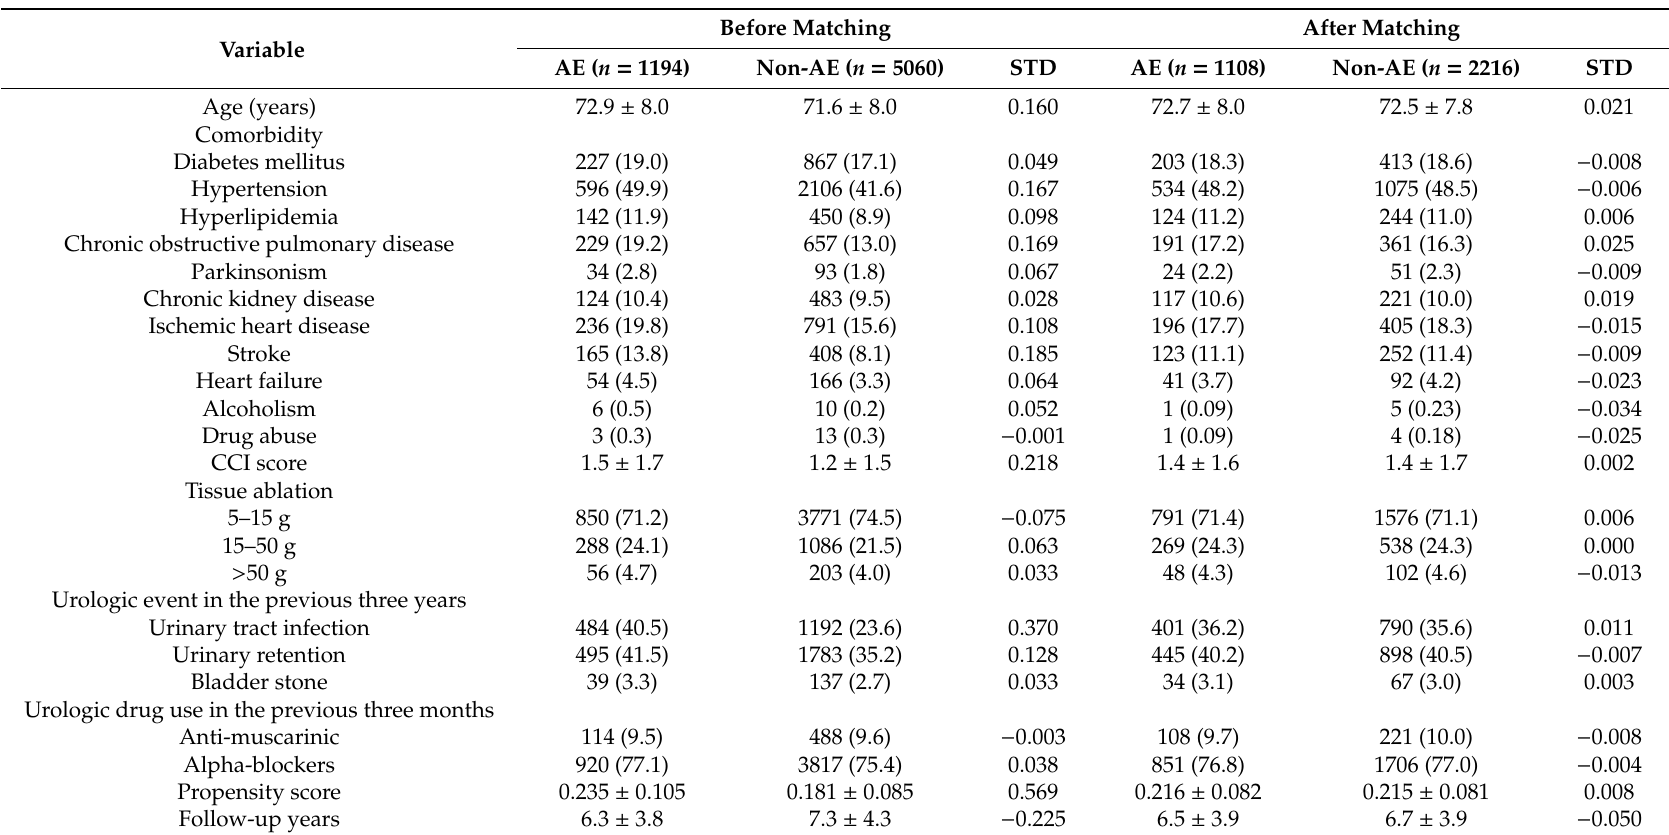
Table 2. Baseline characteristics of patients with BPH who received TURP grouped according to the presence or absence of AEs during the six-month follow-up period.